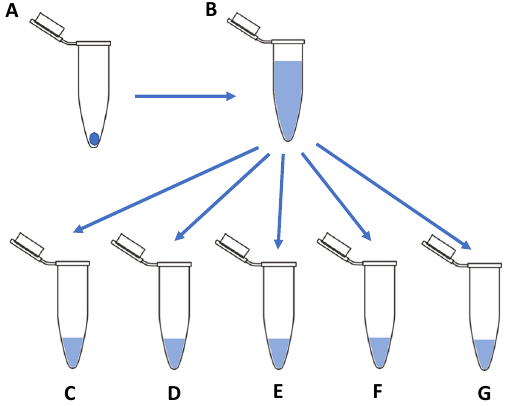
Figure 1. Schematic representation of the methodology used to determine the storage stability of lyophilised and reconstituted FGF-2 solutions. Lyophilised FGF-2 samples ( A ) were stored at − 4 ◦ C, 4 ◦ C or 18 ◦ C for up to 12 months. At defined time points, samples were reconstituted with 50 µ L of water ( B ). The reconstituted FGF-2 solution was divided into 10- µ L aliquots ( C – G ) with one aliquot ( C ) immediately analysed for FGF-2 content, and the remaining stored at 4 ◦ C for 24 h ( D ) and 7 days ( E ), and at 18 °C for 24 h ( F ) and 7 days ( G ) before analysis for residual FGF-2 content by ELISA.